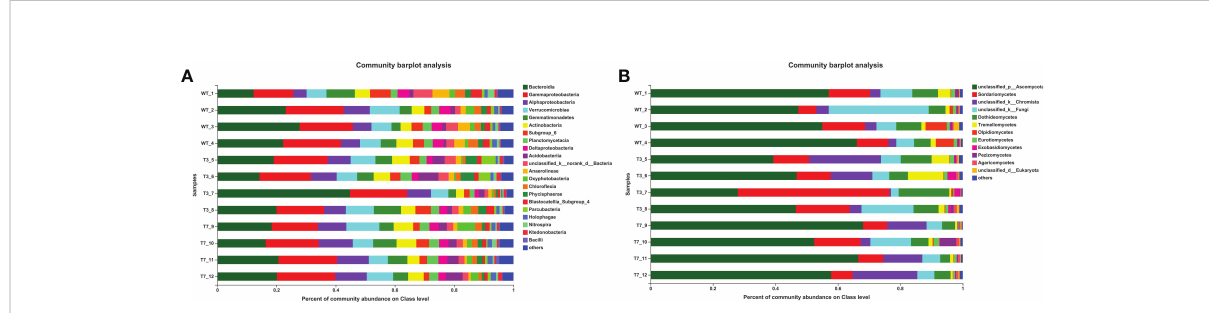
FIGURE 2 Percent of community abundance at the class level of wild-type and transgenic rapeseed plants ( A , bacteria; and B , fungi). Note: The different colors of the column represent different species, and the length of the column represents the size of the proportion of the species.